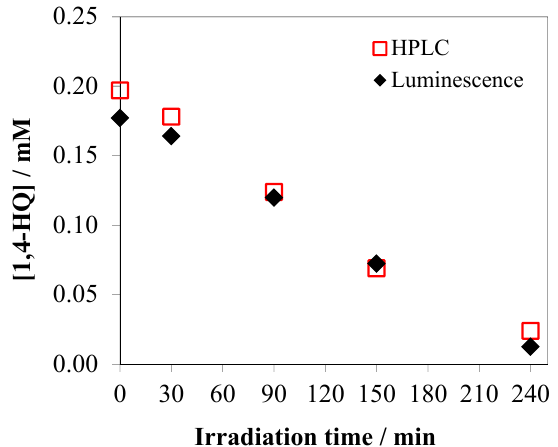
Figure 12. Comparison of HPLC and luminescence method for monitoring of photocatalytic 1,4-HQ degradation over NT-U catalyst.